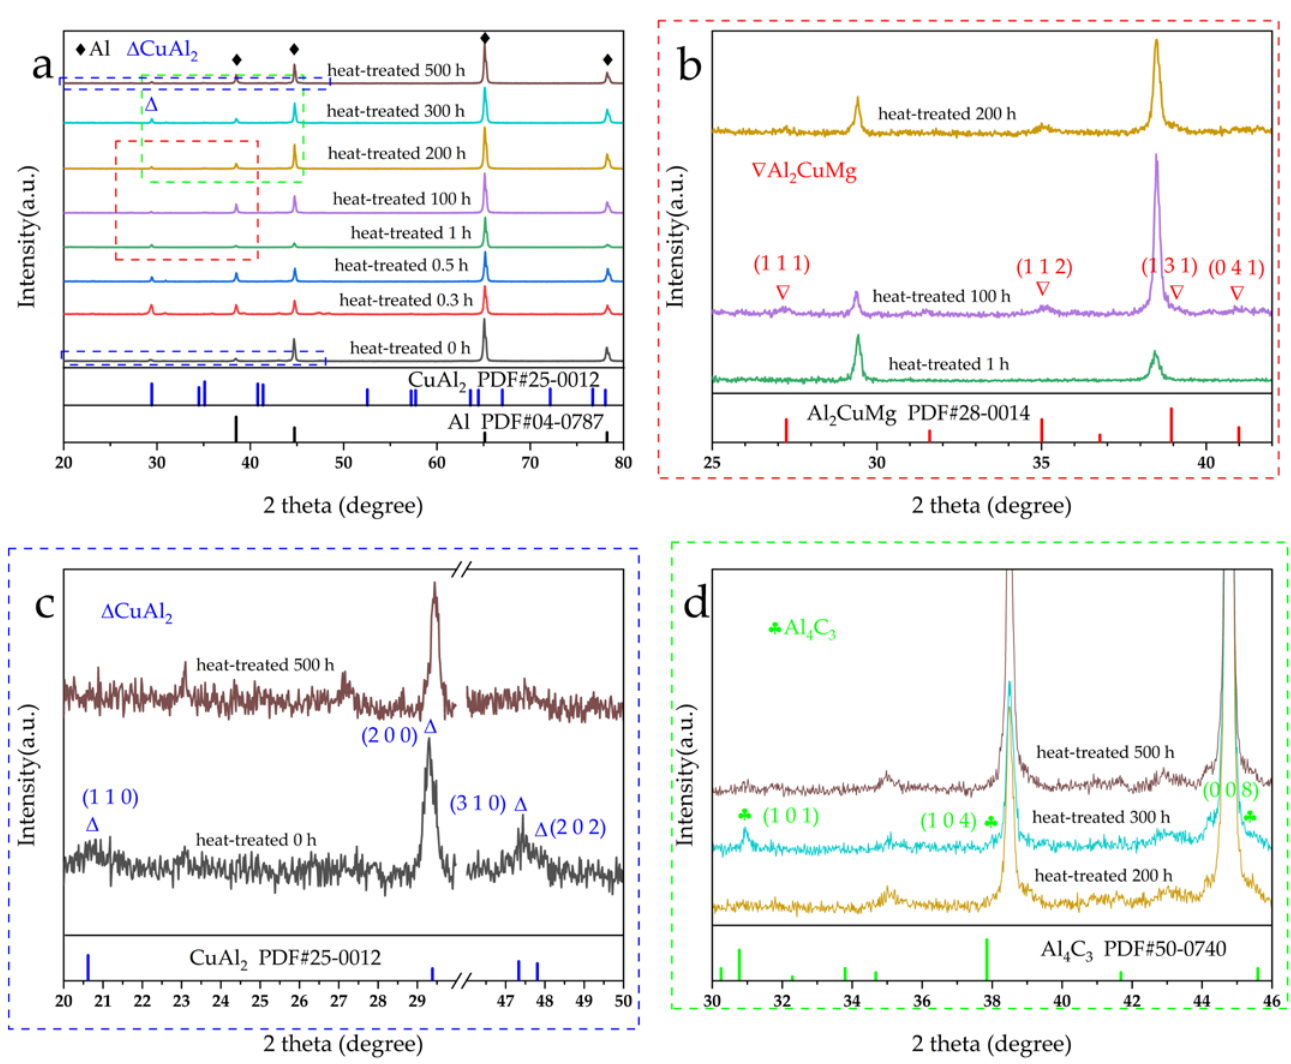
Figure 4. ( a ) XRD patterns of SCFs/2024 Al, with a heat-treated time range from 0 h to 500 h at 160 °C; ( b ) the red dotted area in Figure 4a; ( c ) the blue dotted area in Figure 4a; ( d ) the green dotted area in Figure 4a. From the results of XRD, it can be judged that the grains of Al 2 CuMg and Al 4 C